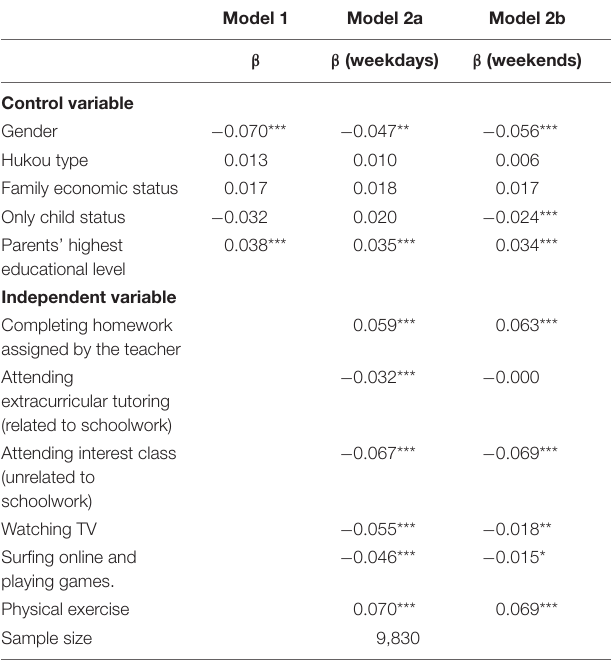
TABLE 3 | Fixed effect model of extracurricular activities on junior high school students’ cognitive